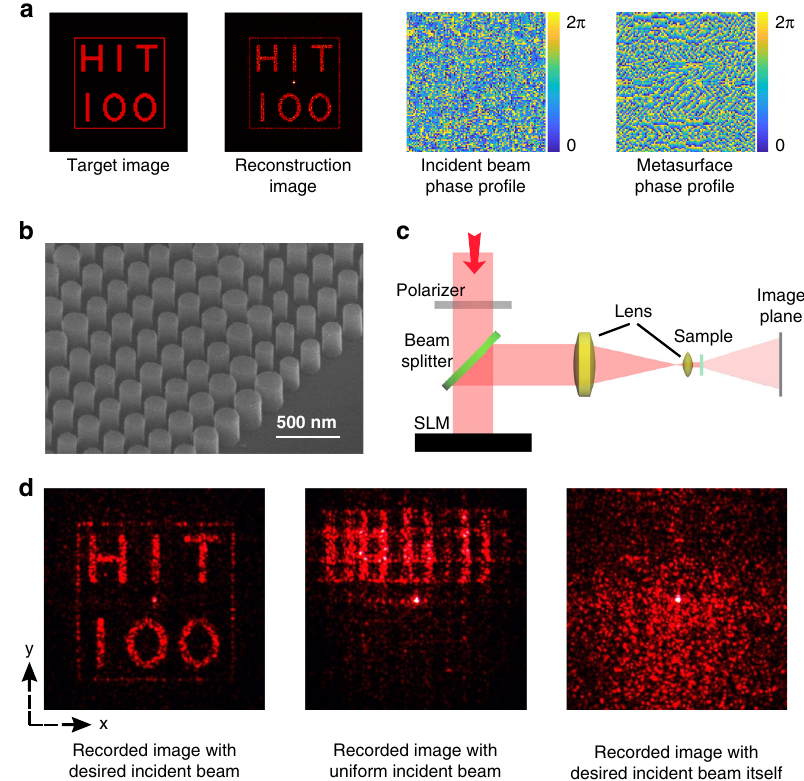
Fig. 2 The experimental demonstration of meta-hologram. a The designed image, the simulated holographic image, and two separated phase pro fi les. b The top-view SEM of the Si metasurface. c Schematic for capturing the meta-hologram. d The recorded meta-holographic images with the designed incident beam (left), with a uniform laser beam (middle), and the image of incident laser itself (right). Here the lattice size is L = 240 longitudinal deviation from the focal point) and pixel sizes are barely recover the encrypted information. This is even higher known, and matched one another. Without the above informa- than the recently demonstrated metasurface-based ghost imaging tion, it shall consume orders of magnitude longer time to algorithm 8 . Note that the above case is valid for the situation that randomly test the right key for decryption (Supplementary Figs. 6 both of the initial positions ((0,0) point of two matrices and the and 7).